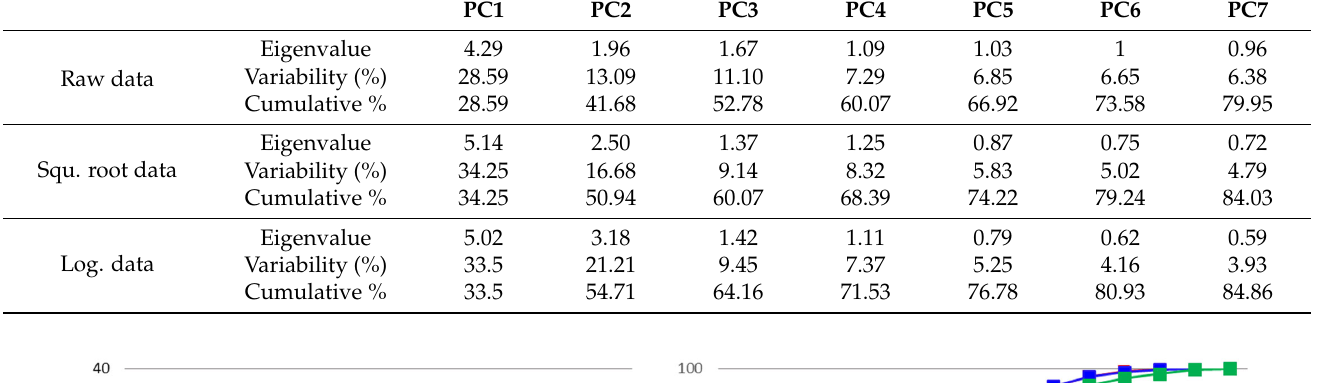
Table 3. Table of variances for PC 1 to PC7 and 3 conditioning modes. Figure 3. Distribution of the observation in the factorial plans PC1 ‐ PC2 and PC3 ‐ PC4 for raw data, square root transformation and log transformation.